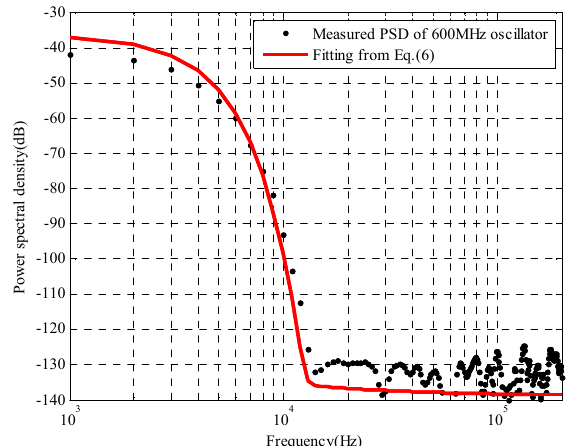
Figure 2. The PSD data fitting by the composite theoretical model ( f 0 = 600 MHz, RMSE = 7.53).